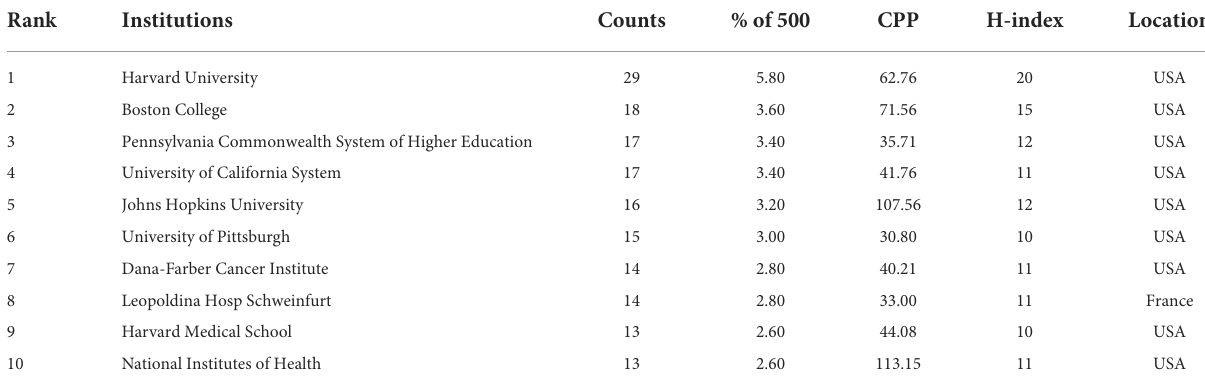
TABLE 3 The top 10 institutions in the field of ketogenic diet on cancer research.